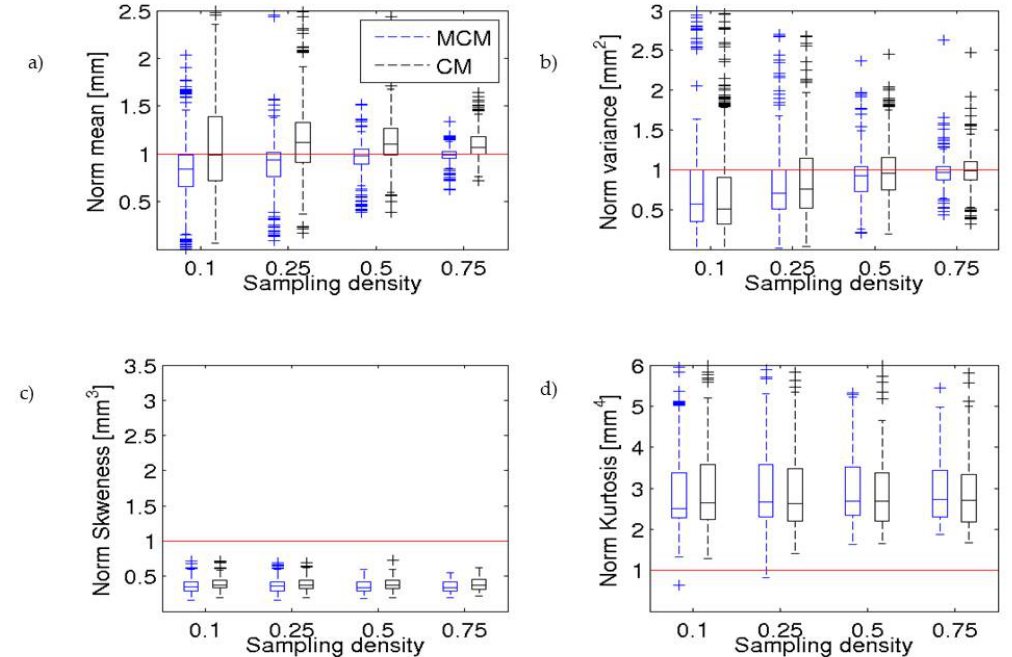
Figure 6. Ensemble of statistical moments varying with density. The subplots indicate ( a ) mean, ( b ) standard deviation, ( c ) skewness, and ( d ) kurtosis.